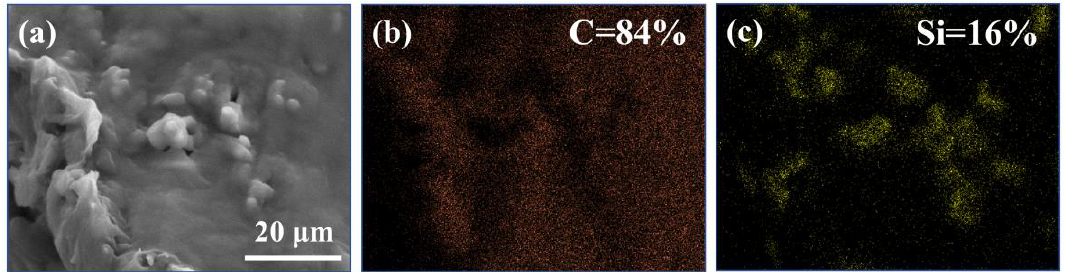
Figure 3. The EDS spectra of ( a ) the paraffin/MSA composites, ( b ) carbon element, ( c ) silica element.